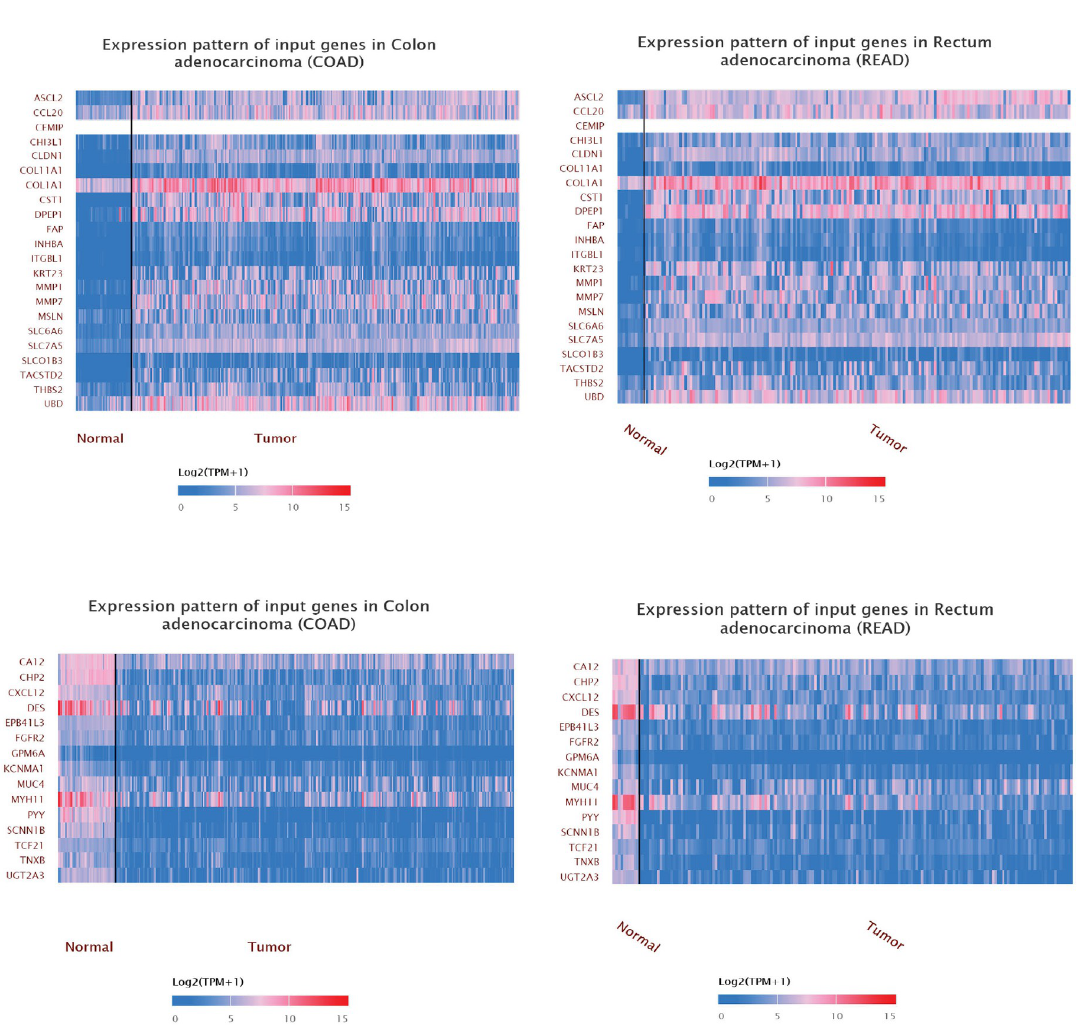
Fig 7. Heatmaps as for expression of validated-Differentially-Expressed-Genes-Differentially-Methylated-Genes (vDEGs-DMGs) based on TCGA data. The top left corner) Expression values of over-expressed/hypo-methylated vDEGs-DMGs in COAD. The bottom left corner) Expression values of under-expressed/hyper-methylated vDEGs-DMGs in COAD. The top right corner) Expression values of over-expressed/hypo-methylated vDEGs-DMGs in READ. The bottom right corner) Expression values of under-expressed/hyper- methylated vDEGs-DMGs in